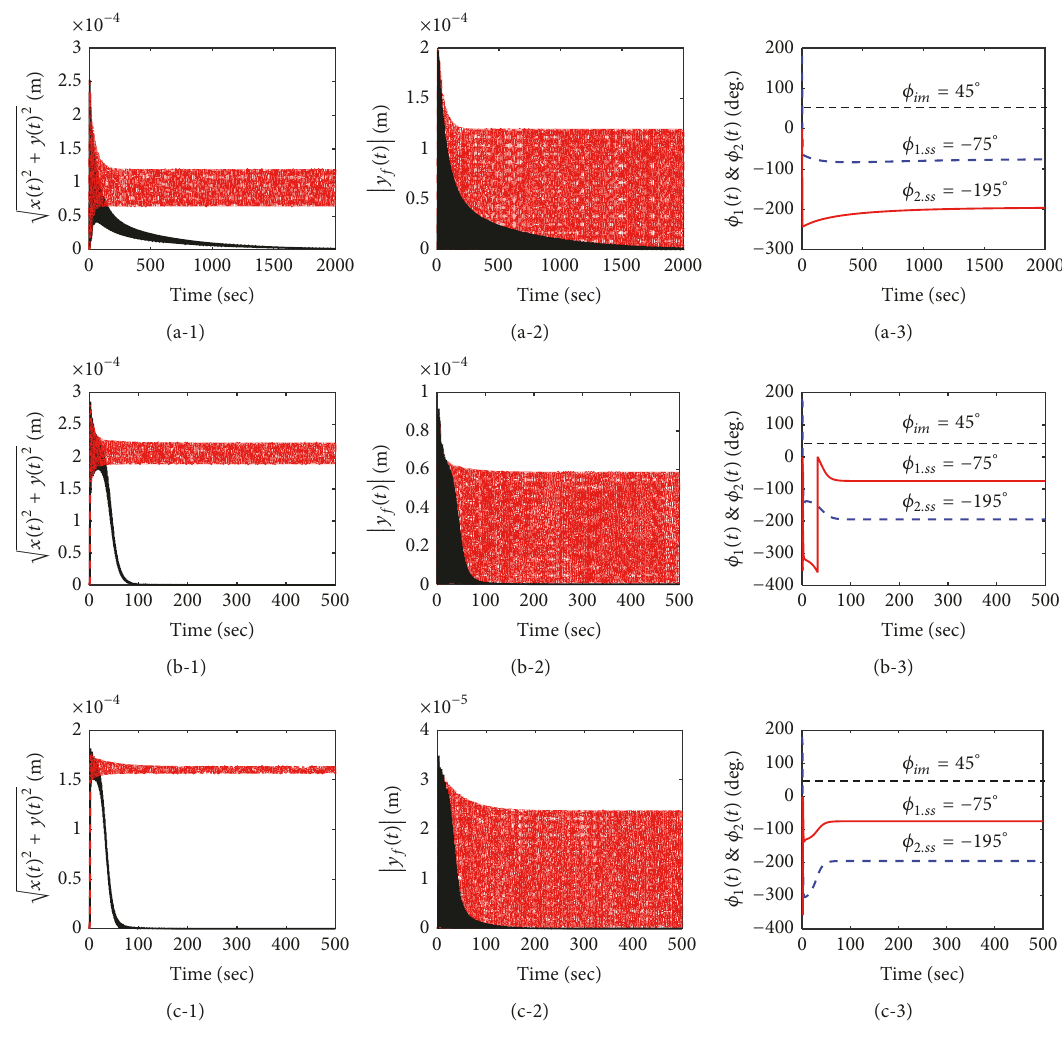
Figure 3: Balancing responses of system on time domain ((a-1) through (a-3) at Ω = 1.25 , (b-1) through (b-3) at Ω = 2.58 , and (c-1) through (c-3) at Ω = 4.12